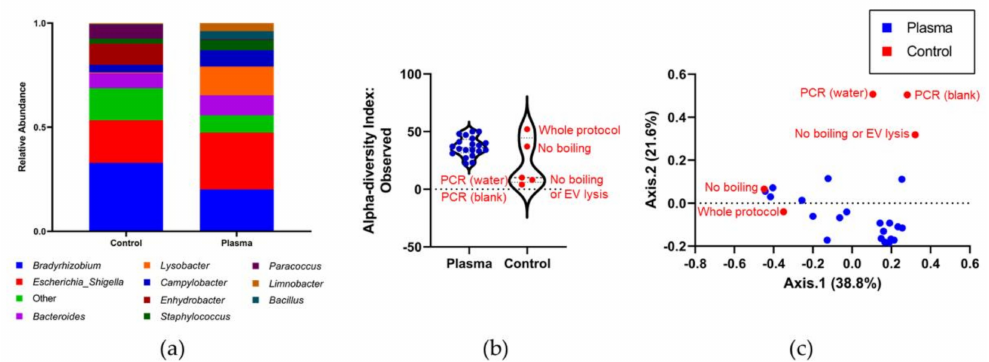
Figure 4. Taxonomic profiles between protocol control samples and plasma are distinct. ( a ) The relative abundance chart shows the top 10 most dominant taxa at the genus level. ( b ) Microbial richness measured by α -diversity in protocol controls was lower than that of plasma samples in three cases but comparable to plasma in two (ASV-level Observed Index: number of unique ASVs observed per sample). ( c ) The β -diversity PCoA plot shows that three protocol control samples (red) form a cluster that is significantly distinct from the plasma samples; however, two samples cluster alongside plasma (blue) (ASV-level; Bray–Curtis Index). Violin plot with individual values demonstrating frequency distribution: dotted lines represent the upper and lower quartiles, and the central dashed line represents the